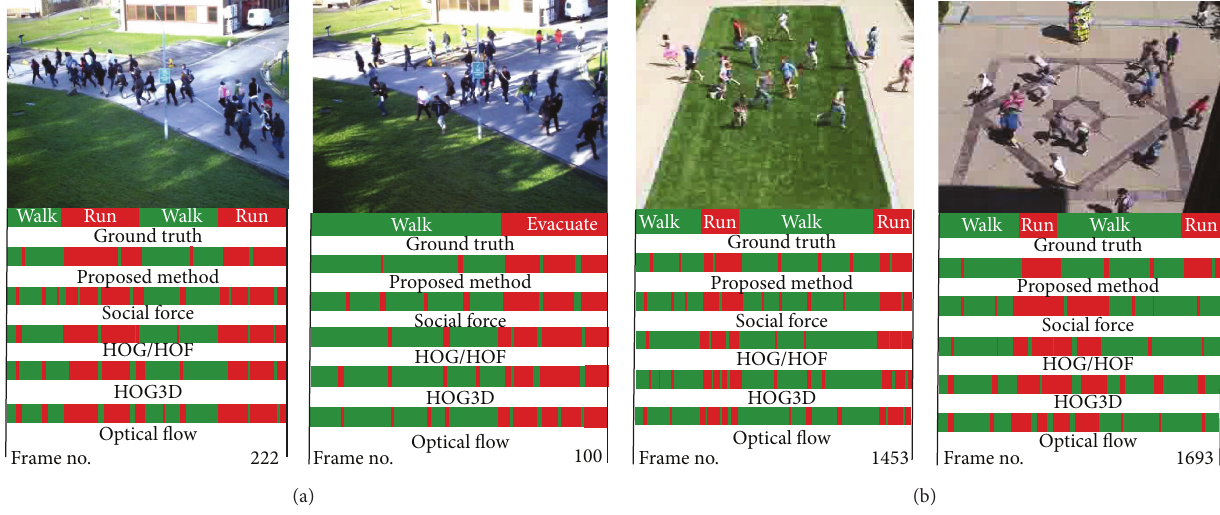
Figure 9: The qualitative results of the crowd behavior perception for four sample videos. (a) are sample results from Seq. 1, and (b) are sample results from Seq. 2. The bars are utilized to represent the labels of each frame for the videos in the sample video, and different colors represent the different corresponding crowd behaviors. The bars indicate the ground truth, the detection results based on the proposed spatiotemporal Weber field, social force model [24], HOG/HOF [36], HOG3D [37], and pure optical flow [8], respectively.